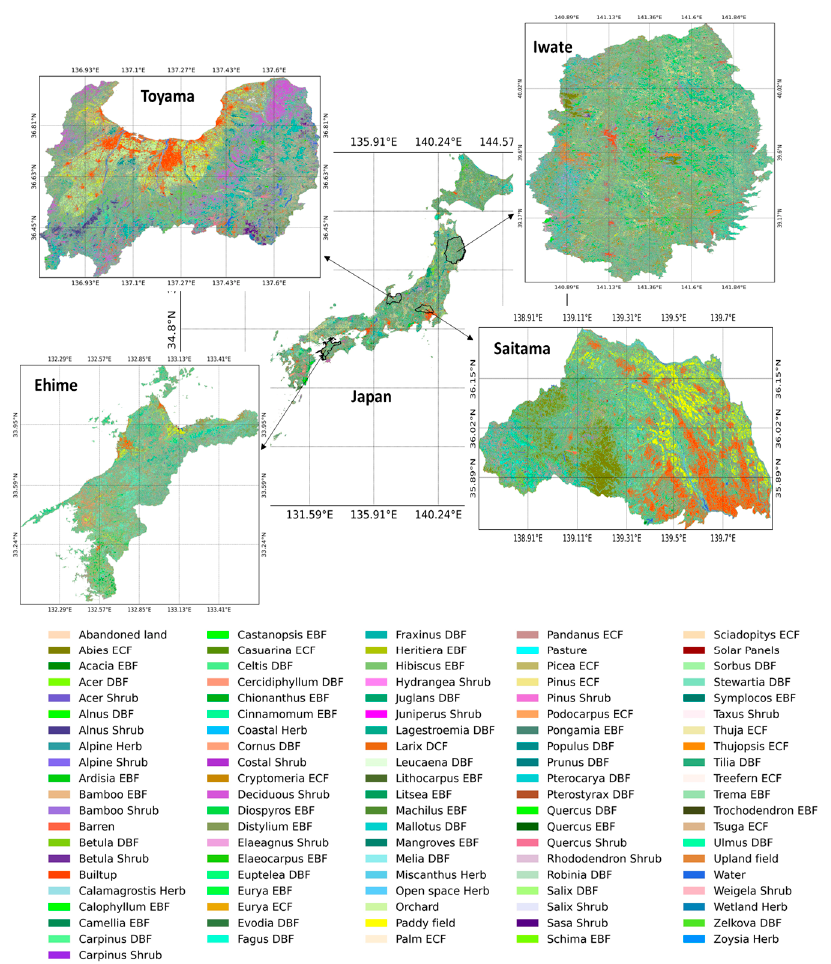
Figure 3. Plant ecological communities map produced at a country scale.